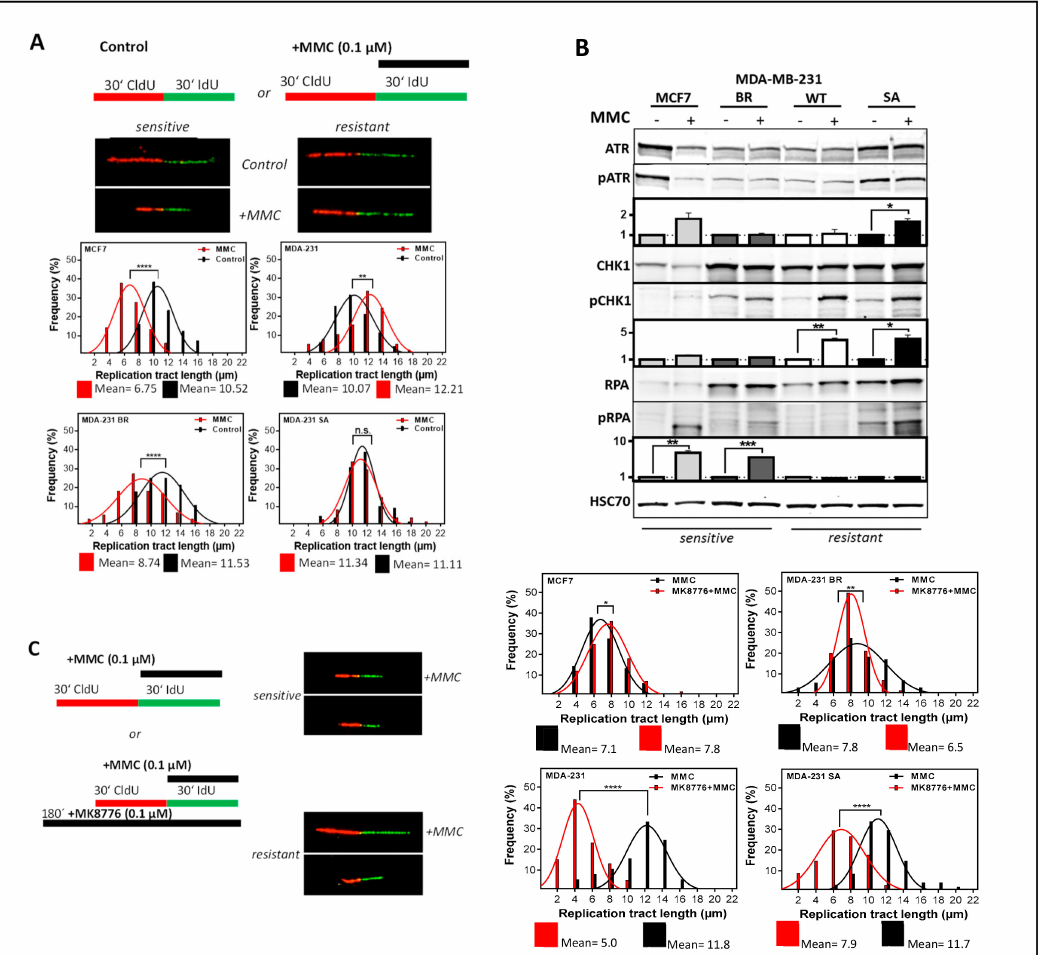
Figure 4. CHK1 inhibition leads to increased replication stress only in MMC-resistant TNBC. ( A ) Examples and frequency distribution of DNA fiber lengths (CldU) in untreated and MMC treated cells. Exponentially growing cells were sequentially labeled with CldU and IdU in the absence or presence of MMC (0.1 µ M). DNA was spread and incorporated CldU and IdU was detected with appropriate antibodies. Shown are means ± SEM of DNA fiber length (CldU) frequency distributions of three independent experiments. Asterisks represent significant di ff erences (** p < 0.01; *** p < 0.0001, Student’s t -test). ( B ) Immunodetection of activated intra-S phase checkpoint proteins. Cells were treated with 1.5 µ g / mL MMC for 1 h and proteins were extracted 24 h later. Proteins were separated and transferred by Western blotting. Detection of proteins was performed with appropriate antibodies. HSC70 served as the loading control. Phosphorylation of the untreated control was used for standardization and ratios of phosphorylated to non-phosphorylated protein are shown. Data from three independent experiments were used for quantification. Errors are mean values + SEM. ( C ) DNA fiber lengths of CldU labeled tracts after treatment with MMC in the presence of the CHK1 inhibitor MK8776 (1 µ M). Exponentially growing cells were incubated for 2 h with MK8776 and sequentially labeled with CldU and IdU (plus 0.1 µ M MMC), DNA was spread and incorporated nucleotides were detected with the appropriate antibodies. The frequency distribution of DNA fiber lengths in the first label (CldU) of three independent experiments is shown. Asterisks represent significant di ff erences (* p < 0.05; ** p < 0.01; *** p < 0.001; **** p < 0.0001, n.s. not significant; Student’s